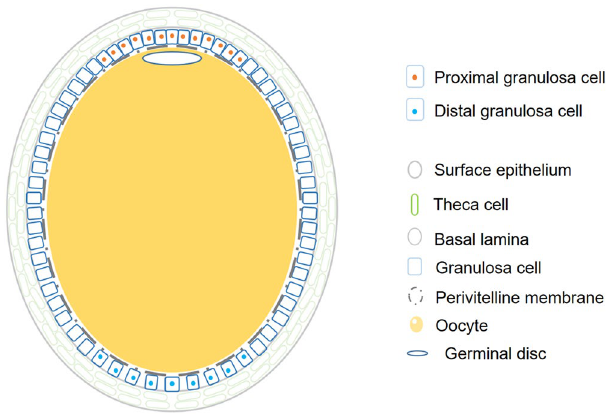
Figure 1. The structural model of chicken preovulatory follicle. The granulosa cells above the germinal disc (Gp) and the granulosa cells distal to the germinal disc (Gd) are